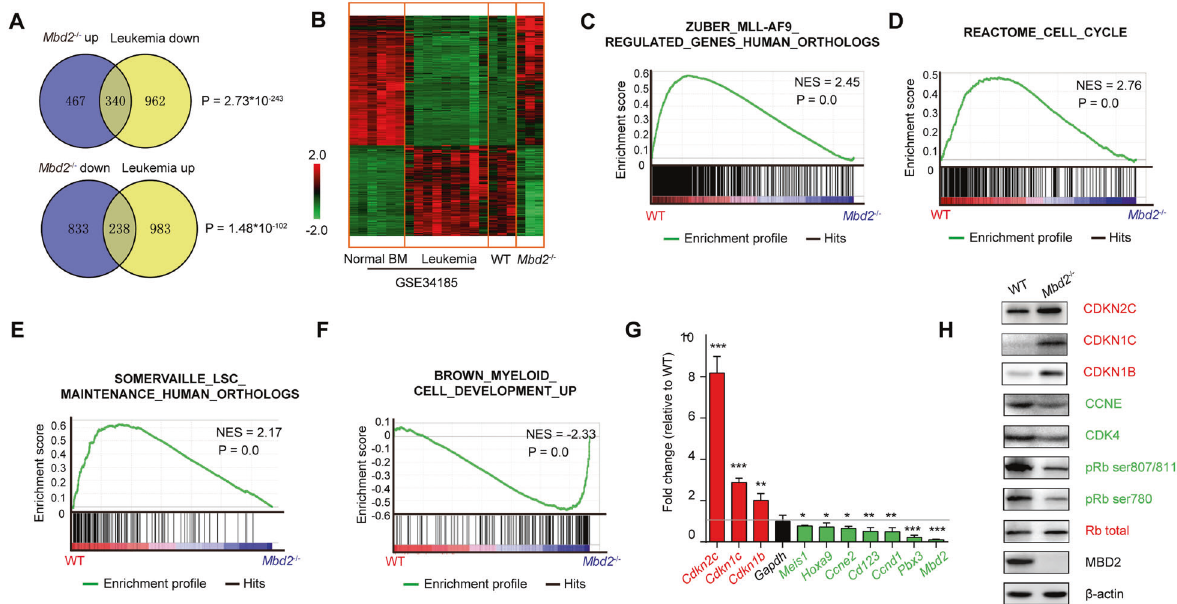
Fig. 4 MBD2 ablation partially reverses the MLL leukemia-associated gene signature and promotes myeloid differentiation, possibly by relieving the transcriptional suppression of cell cycle inhibitors. A Venn diagrams displaying the intersection of reverse DEGs in WT and Mbd2 − / − AML cells from our microarray (blue circle, “ Mbd2 − / − up ” and “ Mbd2 − / − down ” represent the upregulated or downregulated genes in Mbd2 − / − leukemic cells, respectively), and DEGs in leukemia and normal BM from the GSE34185 dataset (yellow circle, “ leukemia up ” and “ leukemia down ” represent the upregulated or downregulated genes in AML cells, respectively). B Unsupervised hierarchical clustering was performed using the common DEGs from the GSE34185 dataset and our microarray dataset. C – F GSEA shows decreased expression of the MLL-AF9 leukemia signature ( C ), downregulation of the cell cycle signature ( D ), loss of the leukemia self-renewal gene expression program ( E ), and increased expression of the myeloid differentiation signature ( F ) in Mbd2 − / − cells relative to WT cells. NES, normalized enrichment score. G Validation of the microarray data of typical cell cycle regulators and MLL rearrangement target genes by qRT-PCR. The level of transcripts in WTAML cells was set at 1.0. Bars represent the mean ± s.d. of two independent experiments. H Expression levels of typical cell cycle regulators in WT or Mbd2 − / − MLL-AF9 cells were determined by WB. β -Actin was used as an internal control. * P < 0.05, ** P < 0.005, and *** P <